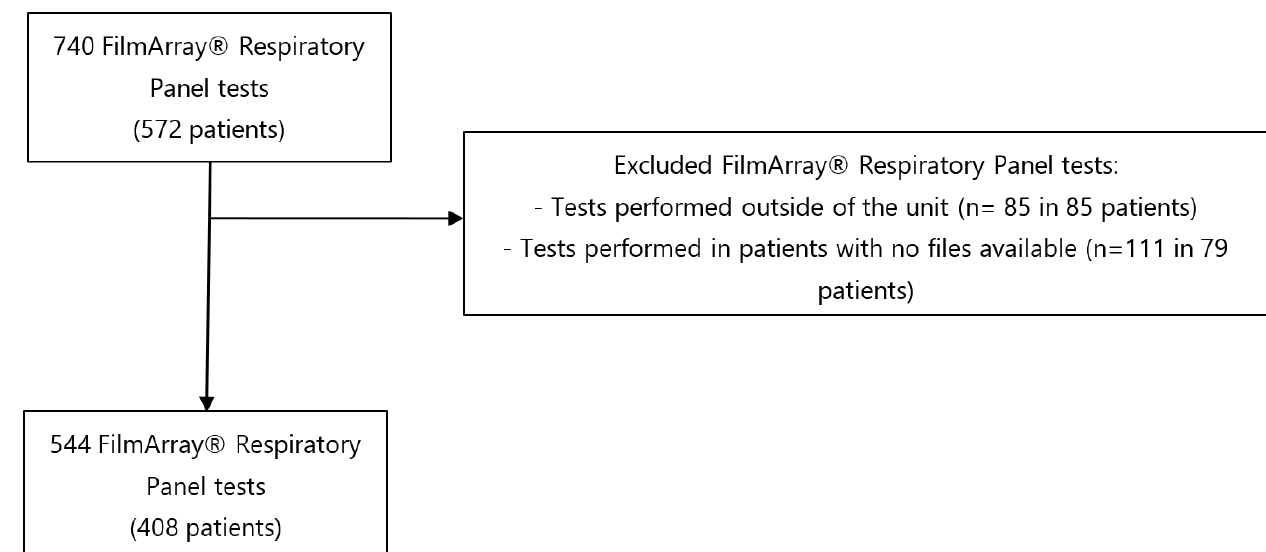
Figure 1. Flow chart of FilmArray ® Respiratory Panel tests included. Table 1. Characteristics of patients corresponding to each FilmArray ® Respiratory Panel test.